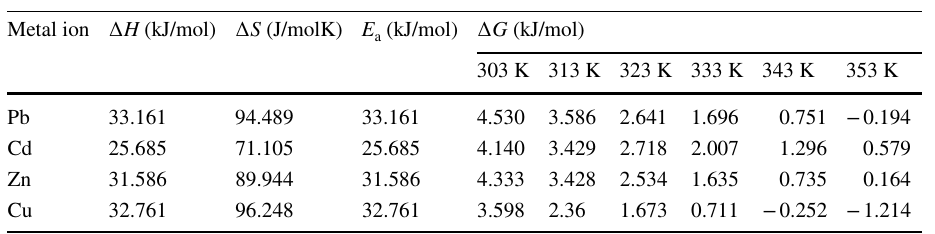
Table 1 Thermodynamic parameters of Pb, Cd, Zn and Cu ion removal from aqueous solution by Albizia lebbeck pod